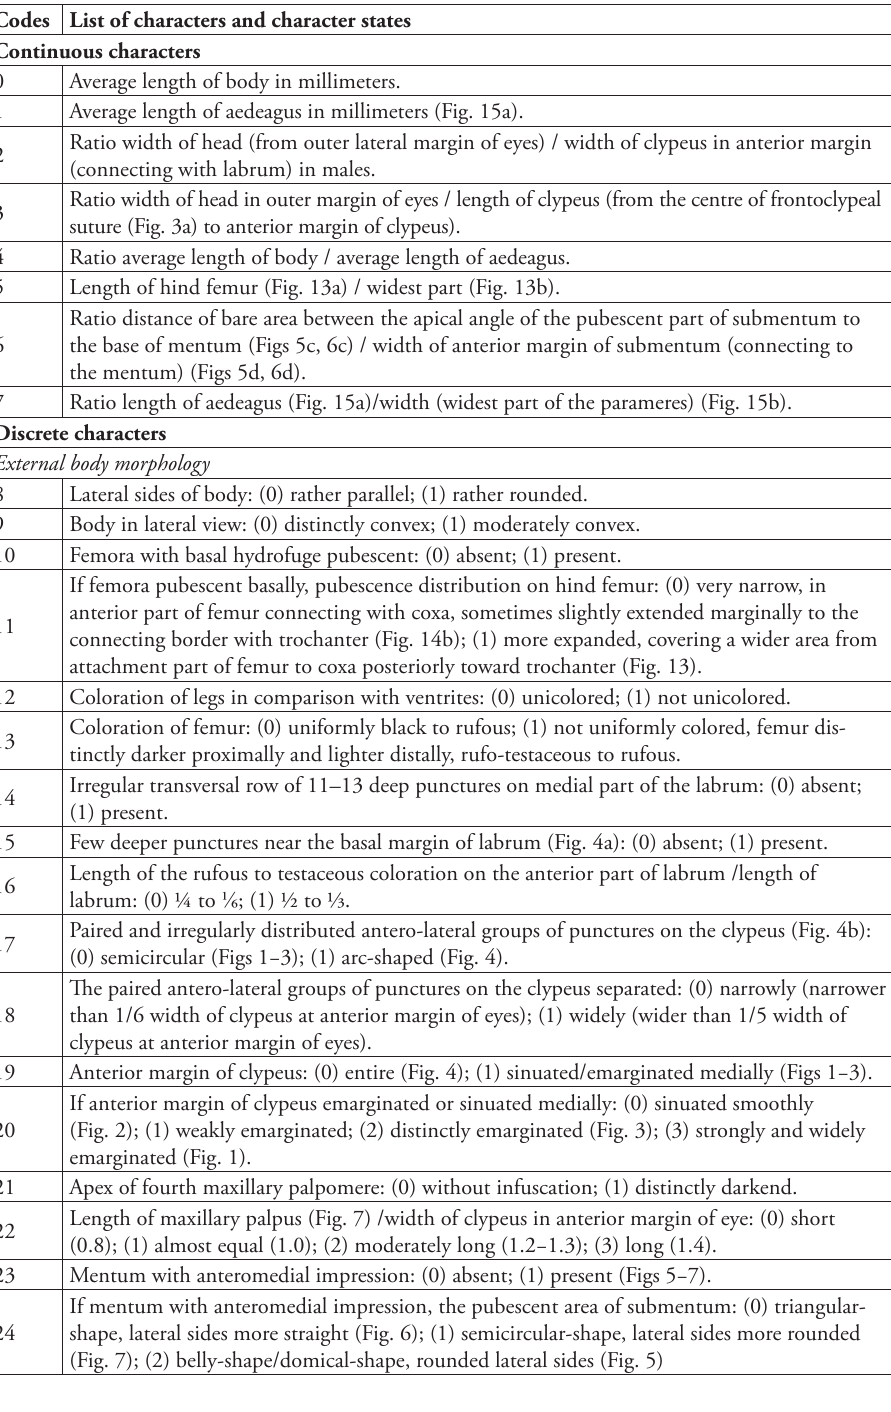
Table 1. List of morphological characters, character states, and codes. Codes List of characters and character